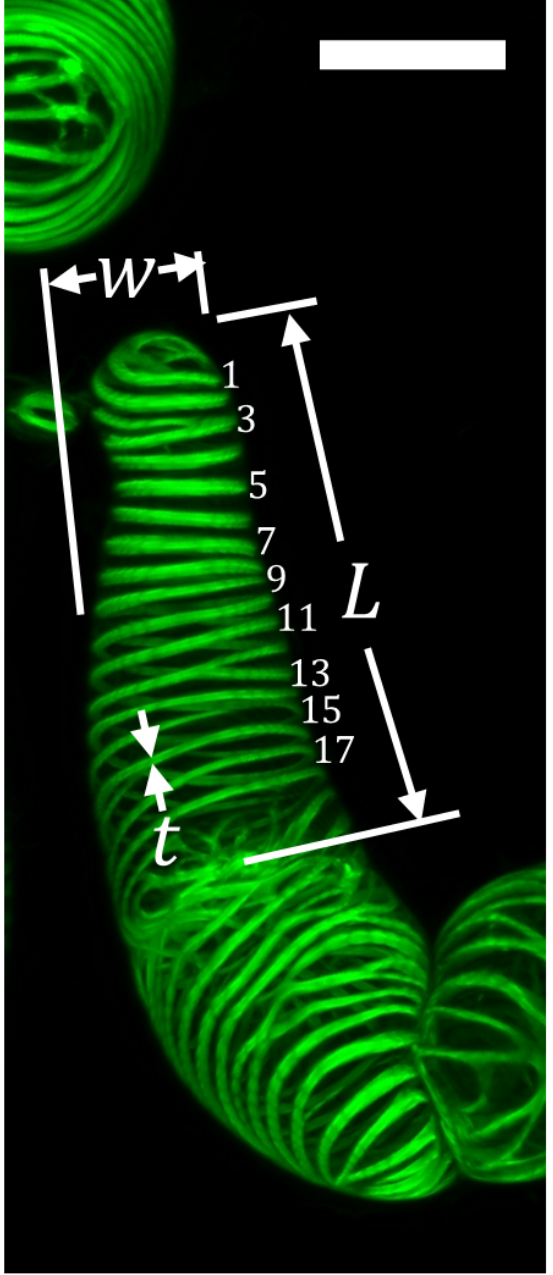
Figure 2. Illustration of measured principal dimensions and feature sizes of elongated VND7-inducible cells from confocal fluorescent microscopy image. Scale bar is 20 µ